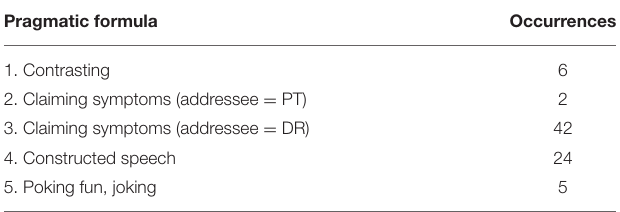
TABLE 6 | The occurrence of illocutionary acts related to